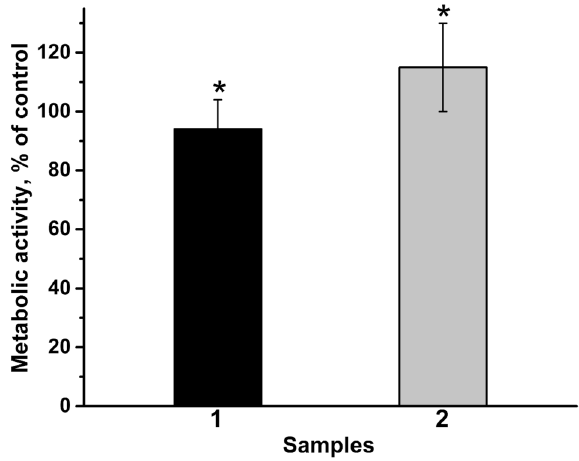
Fig. 6 MTT test: NCTC L929 cells ’ metabolic activity during 24 h of incubation with extracts from materials: 1- β -TCP, 2-Zn- β -TCP cement (* p < 0.01). Control sample (glass slide) is 100%. The error bars correspond to average ± standard